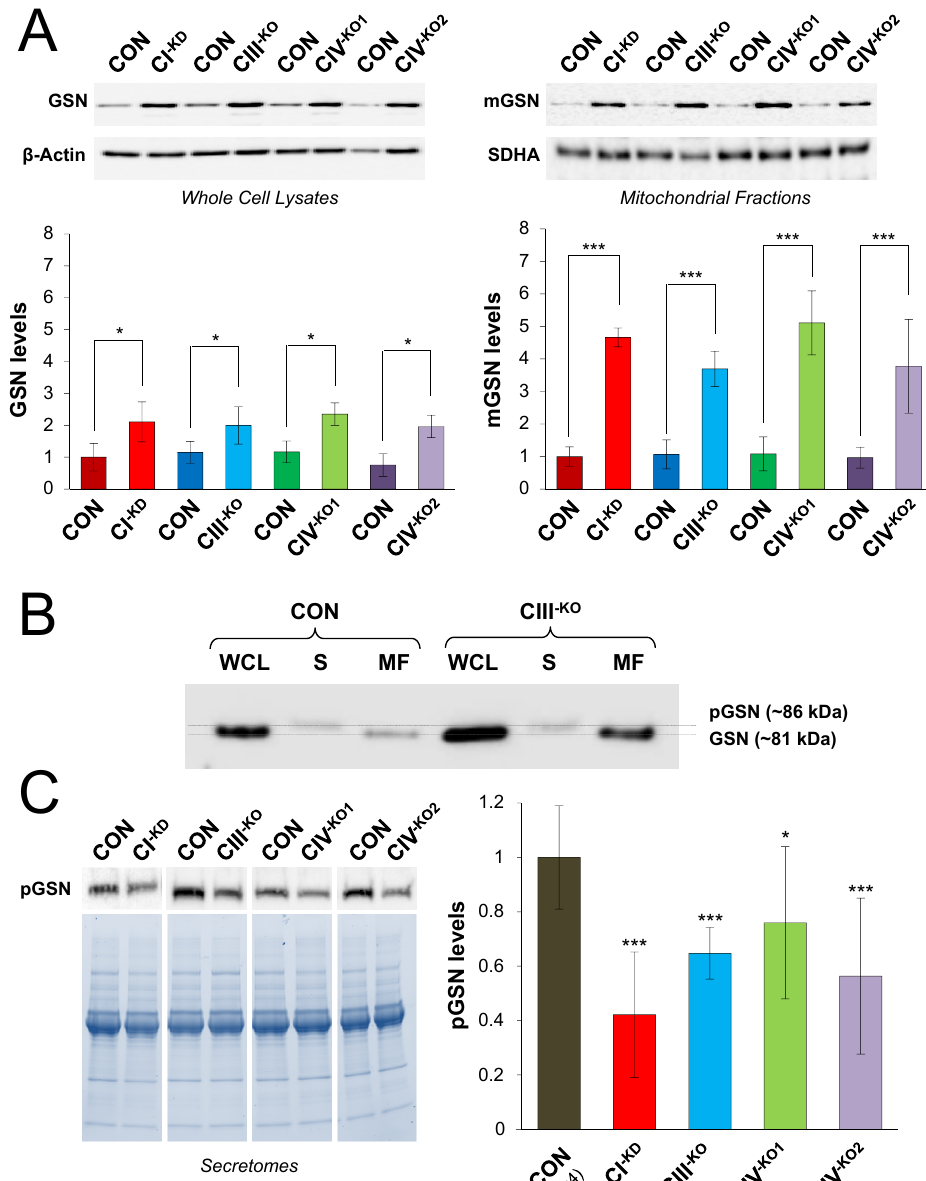
Figure 2. Relative expression of gelsolin isoforms in mitochondrial and secreted protein extracts from mutant transmitochondrial cybrids. ( A ) In total, 15 µ g of protein extracts from control (CON) and transmitochondrial mutant cybrids (CI − KD , CIII − KO , CIV1 − KO , and CIV2 − KO ) were separated on 10% SDS-PAGE gels. GSN levels were analyzed by immunoblotting in whole-cell lysates and isolated mitochondria, using β –actin as the loading control for the whole-cell lysates, and SDHA for the mitochondrial fractions. The signals from four independent experiments per fraction were quantified, normalized by their respective loading controls, and data are presented as the mean ± SD relative to control values, set as 1. GSN, cytosolic GSN; mGSN, mitochondrial GSN. ( B ) In total, 10 µ g of protein extracts from whole-cell lysates (WCLs) and mitochondrial fractions (MFs), as well as 35 µ g of protein extracts from secreted fractions or secretomes (Ss), were separated by 6% SDS-PAGE. GSN isoforms were analyzed by Western blot. GSN, cytosolic GSN; pGSN, plasma GSN. ( C ) In total, 30 µ g of secreted protein extracts were separated on 4–20% TGX TM Precast Protein Gels (Biorad) and pGSN levels were analyzed by immunoblotting. The signals from six independent experiments were quantified, normalized by the total protein amount per lane, and data are presented as the mean ± SD relative to control values, set as 1. Mann–Whitney U test: * p < 0.05; *** p <